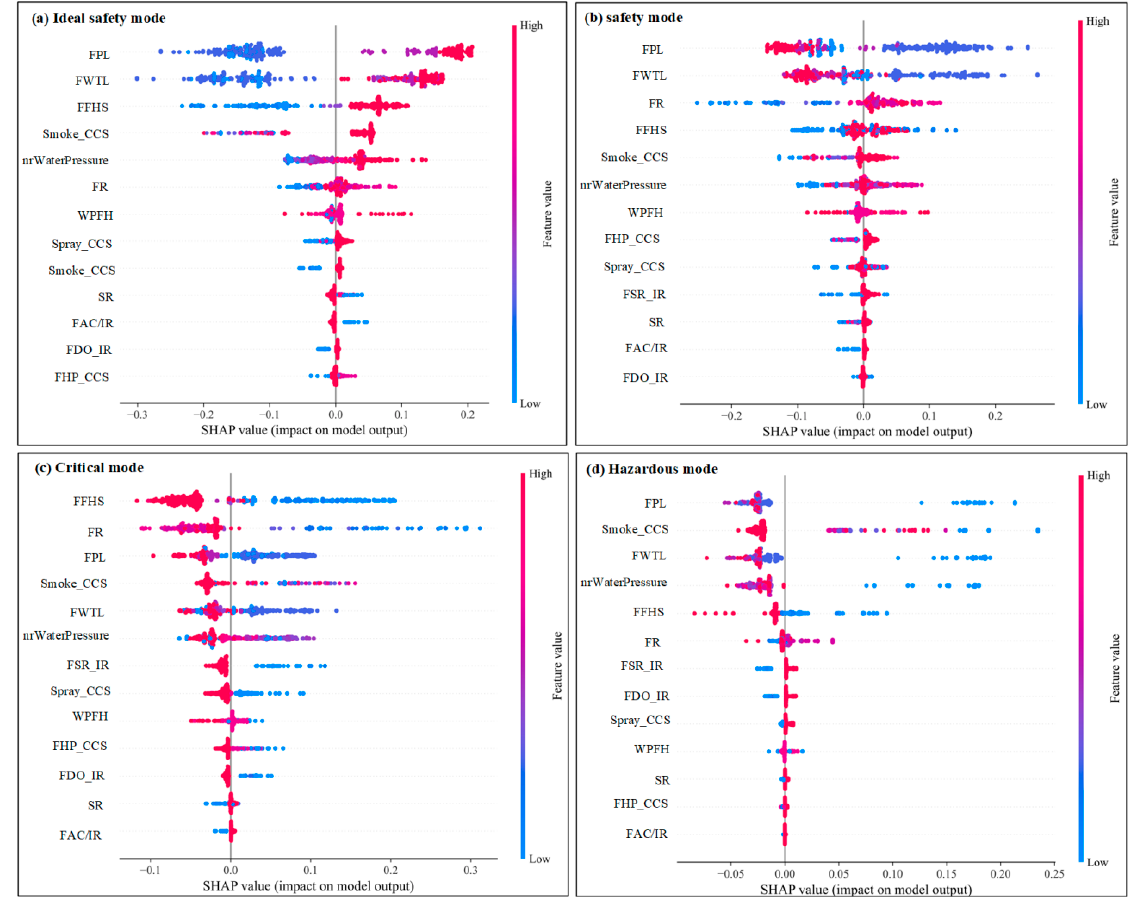
Figure 11. Summary plots for various mode of equipment management